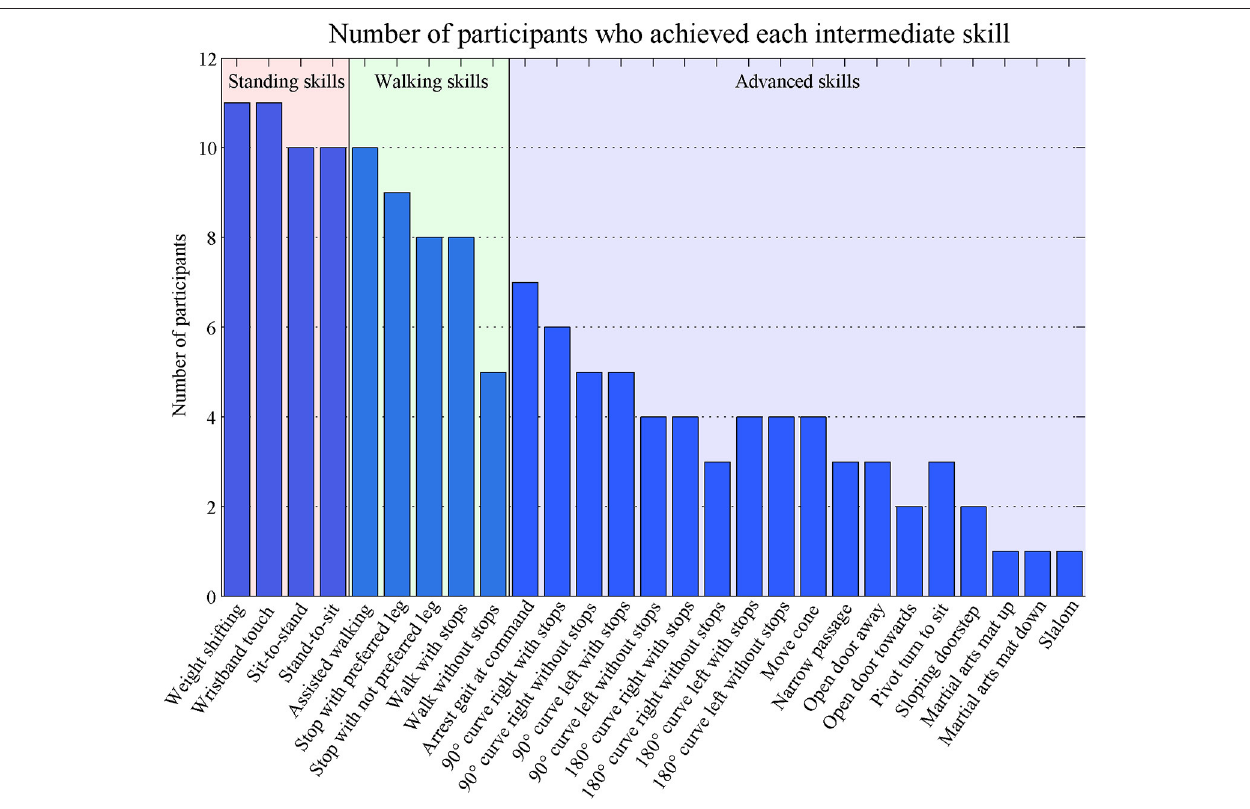
FIGURE 4 | Rates of achievement of each intermediate